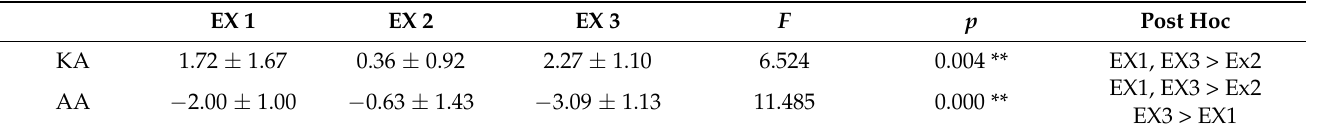
Table 5. Comparative analysis between groups using the average value of change between pre-test and post-test for gait